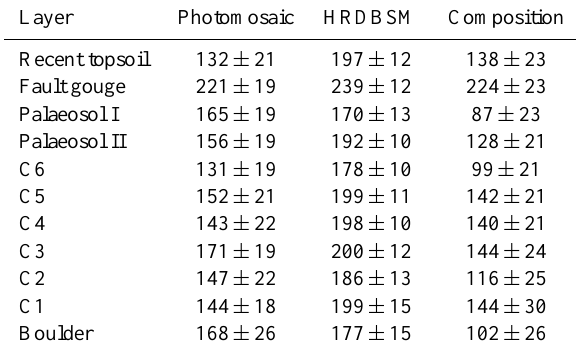
Table 1. Median greyscale values of photomosaic, high-resolution digital backscatter model (HRDBSM), and two-component compo- sition per stratigraphic unit from the trench log. The composition is the result of allocation of photomosaic and HRDBSM in equal parts, to visualise certainties and their variation within given zones. Error is given by single standard deviation. Layer